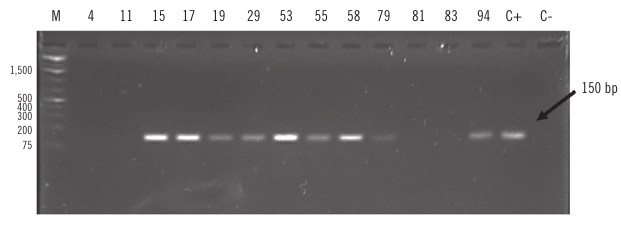
figurE 1 − Photograph of 1.6% agarose gel stained with ethidium bromide as a result of gene amplification of the 16S rRNA (HpX/HpX1) with the expected size of 150 bp